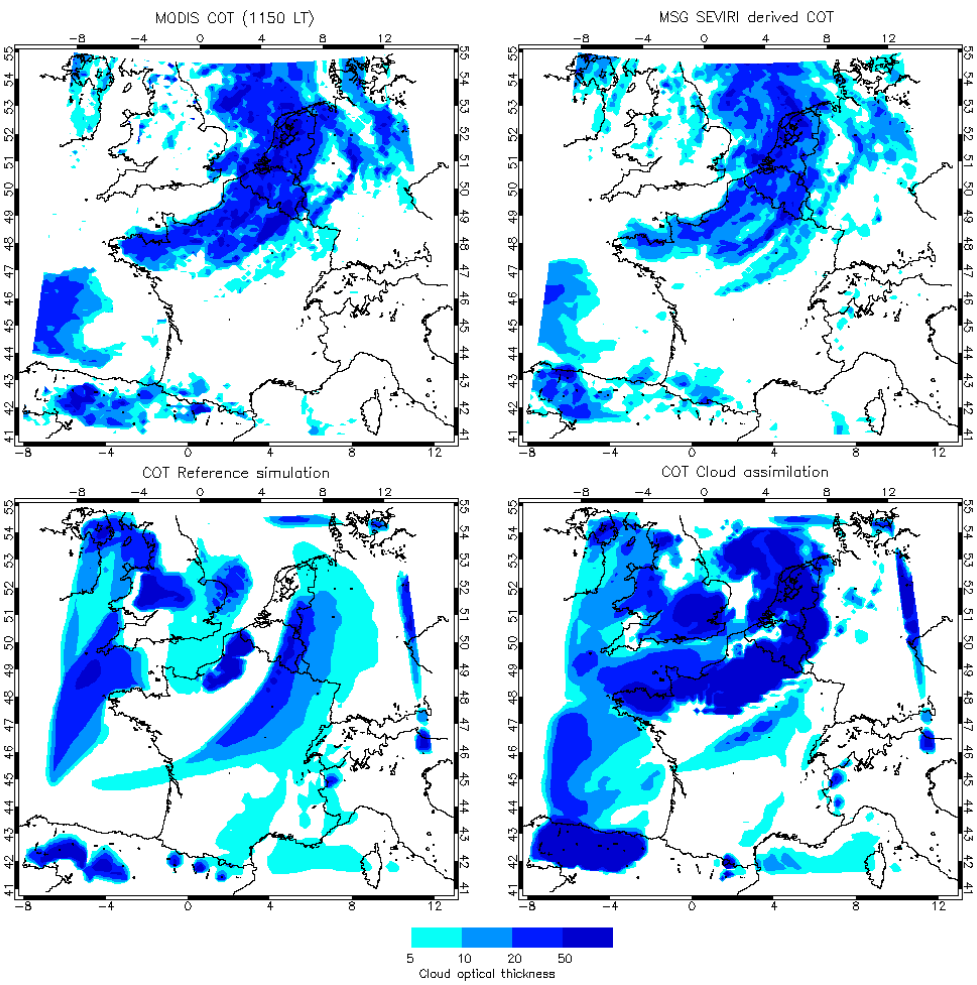
Figure 8: Cloud optical thickness maps on 15 June 2006 at 1200 LT. 3 Fig. 8. Cloud optical thickness maps on 15 June 2006 at 4